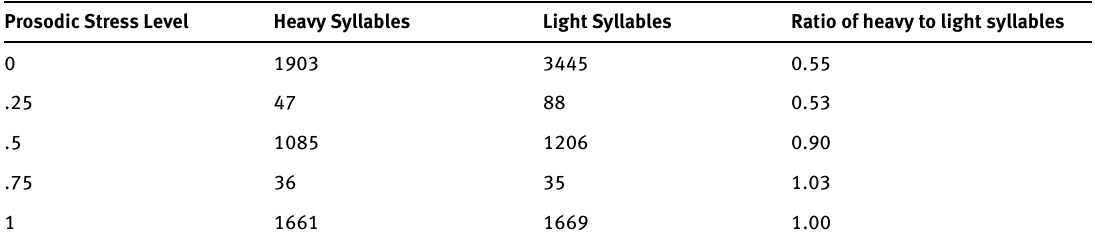
Table 11 Number of Heavy and Light syllables from the STP corpus